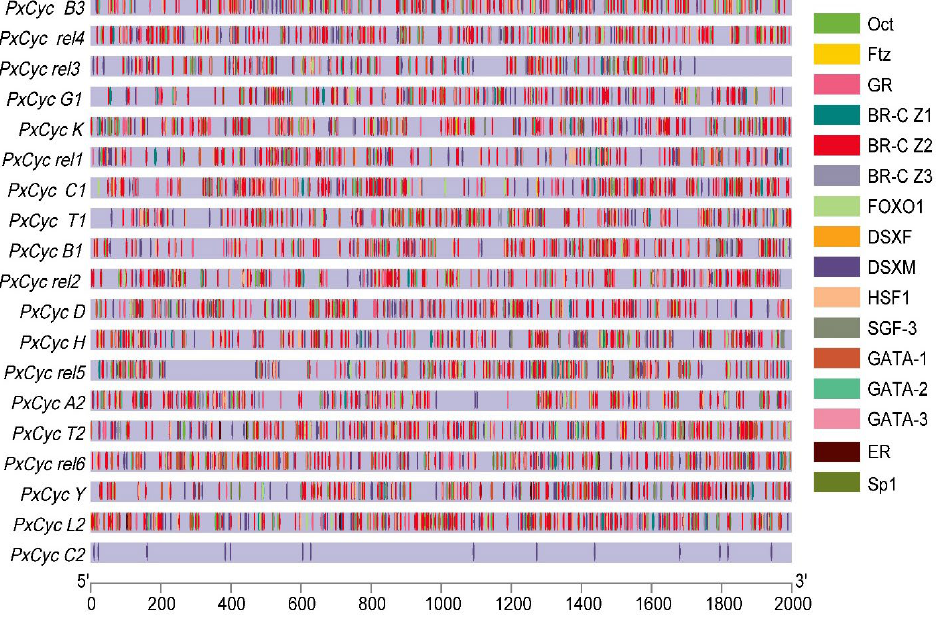
Figure 4. Schematic representation of the transcription factors present in the putative promoter region of cyclin genes of P. xylostella . Different elements are highlighted with different colors, and locations in the promoter are also marked with different colors.